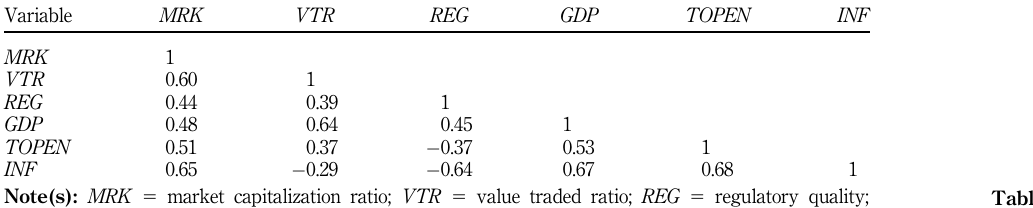
Table 5. Correlation matrix